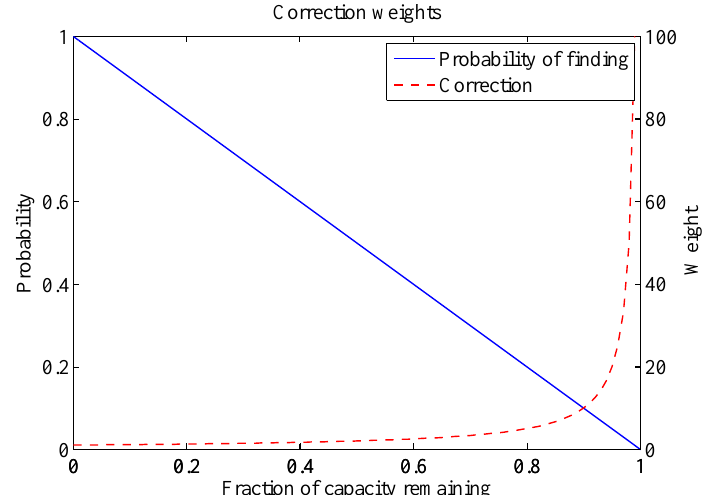
Figure 2. The probability that an incident causes a queue and the correction factor